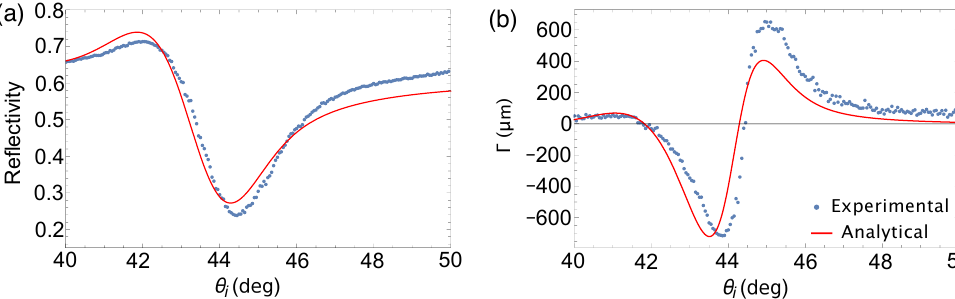
Figure 7. Comparison between analytical and experimental values of ( a ) reflectivity and ( b ) GH shift for a bare Au substrate under focused beam